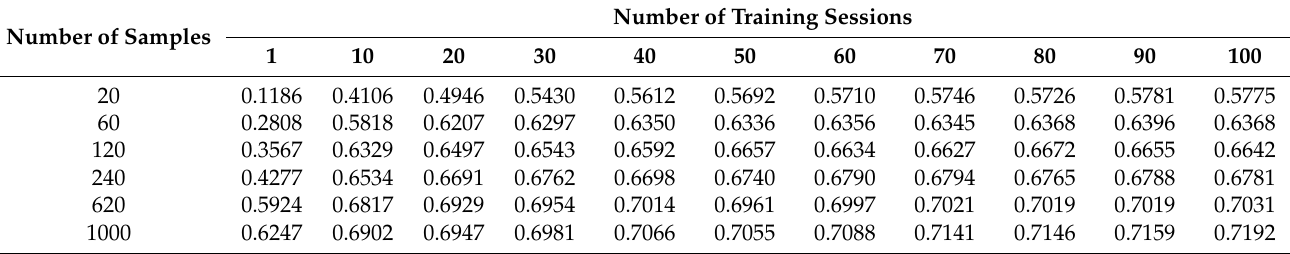
Table 8. Effect of using two fully connected layers.